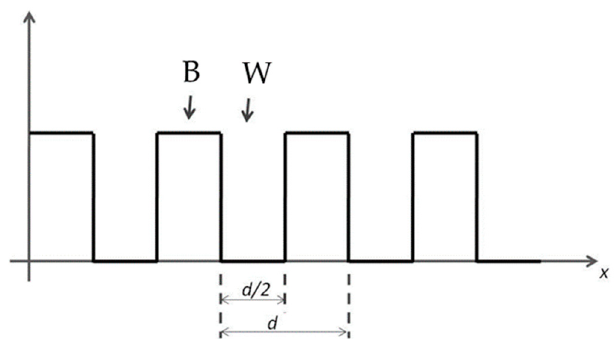
Figure 6. The basic configuration of the barcode.